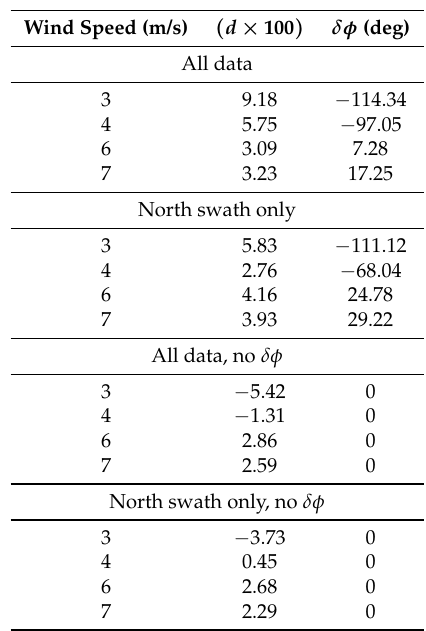
wind speed using all data (first sub-table) and data from the northern swath (second sub-table), which looks into the wind. (bottom two sub-tables) Same as top two subtables, but with the drift velocity parametrized as v d = d | U 10 | cos ( φ r )